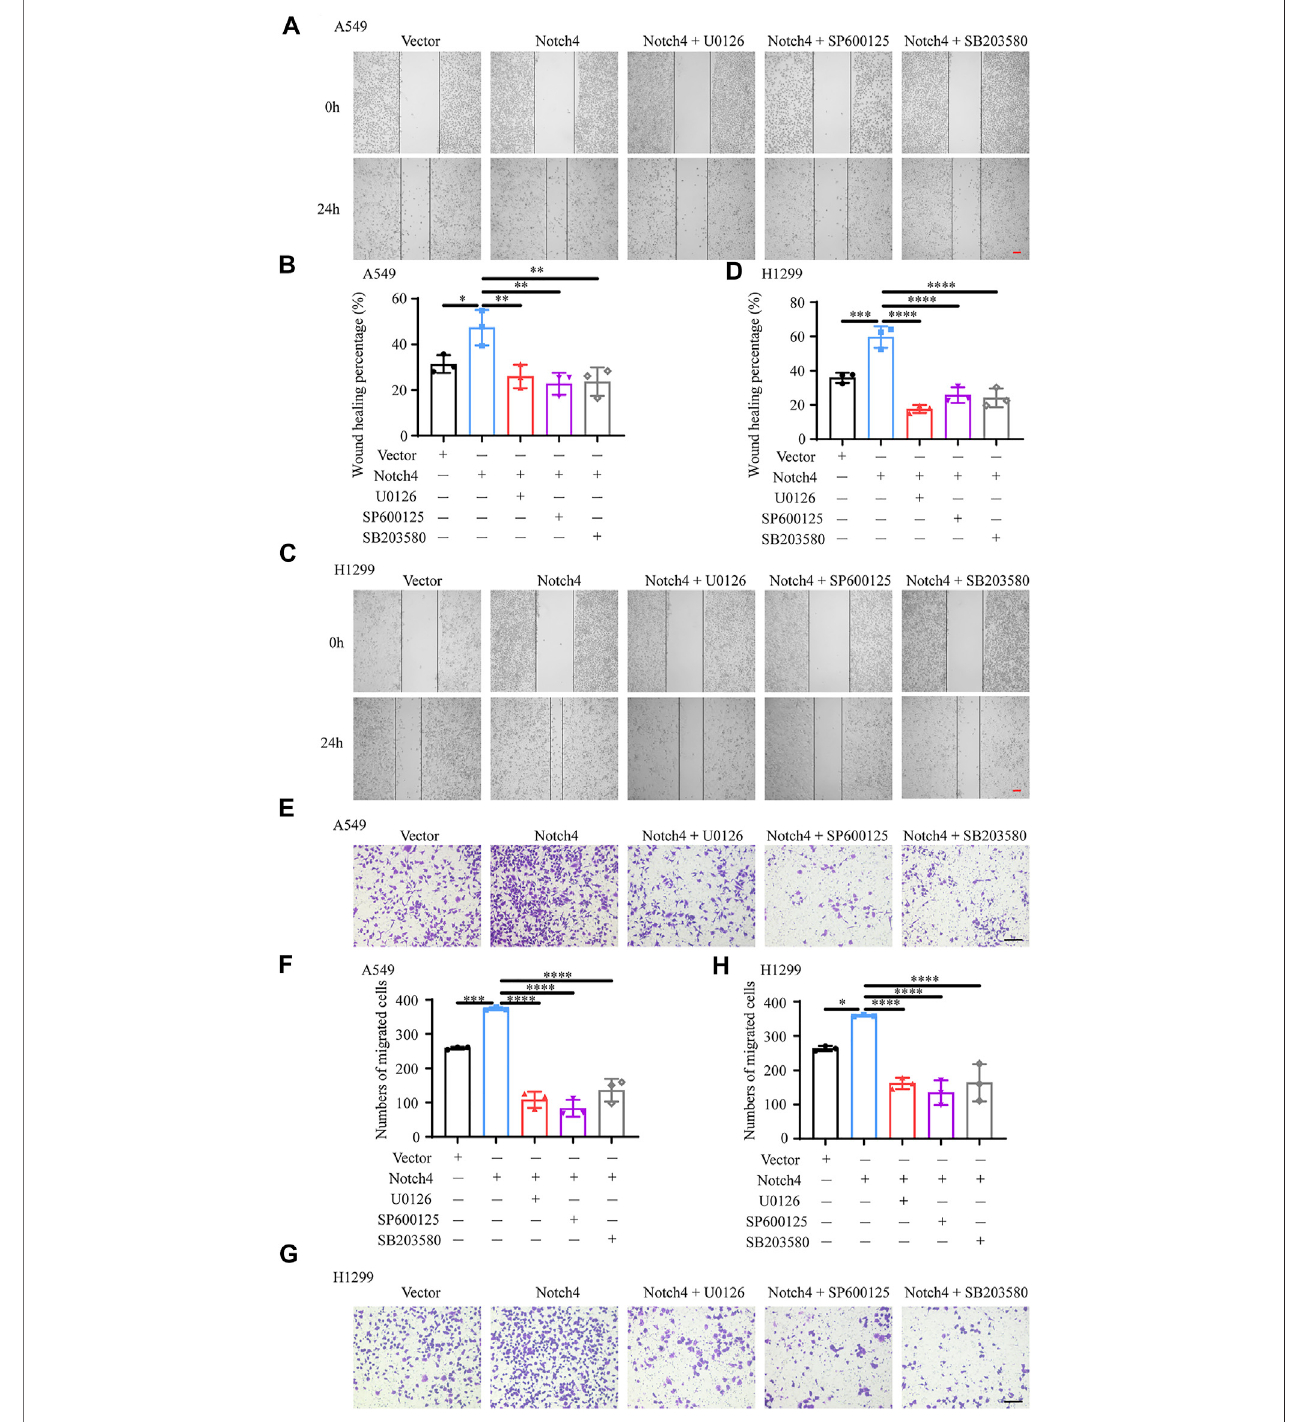
FIGURE6| ERK,JNK,andP38MAPKsignalingmediatetheregulationofNotch4overexpressiononA549andH1299cellsmigration. (A – D) Woundhealingassay was performed in A549 and H1299 cells transfected with Notch4 plasmid or negative control plasmid co-treatment with U0126, SP600125, or SB203580. ( n (cid:2) 3). Magni fi cation, × 40;Bar,200 μ m. (E – H) TranswellmigrationassaywasperformedinA549and H1299 cellstransfected withNotch4 plasmidornegative controlplasmid co-treatment with U0126, SP600125, or SB203580 for 24 h ( n (cid:2) 3). Magni fi cation, × 100; Bar, 50 μ m. Data were presented as means ± SD. * p < 0.05, ** p < 0.01, *** p < 0.001,**** p < 0.0001.Vector,negativecontrolplasmid;Notch4,Notch4plasmid.ERK,extracellularsignal-regulatedkinase;JNK,c-JunN-terminalkinase;MAPK, mitogen-activated protein kinase.